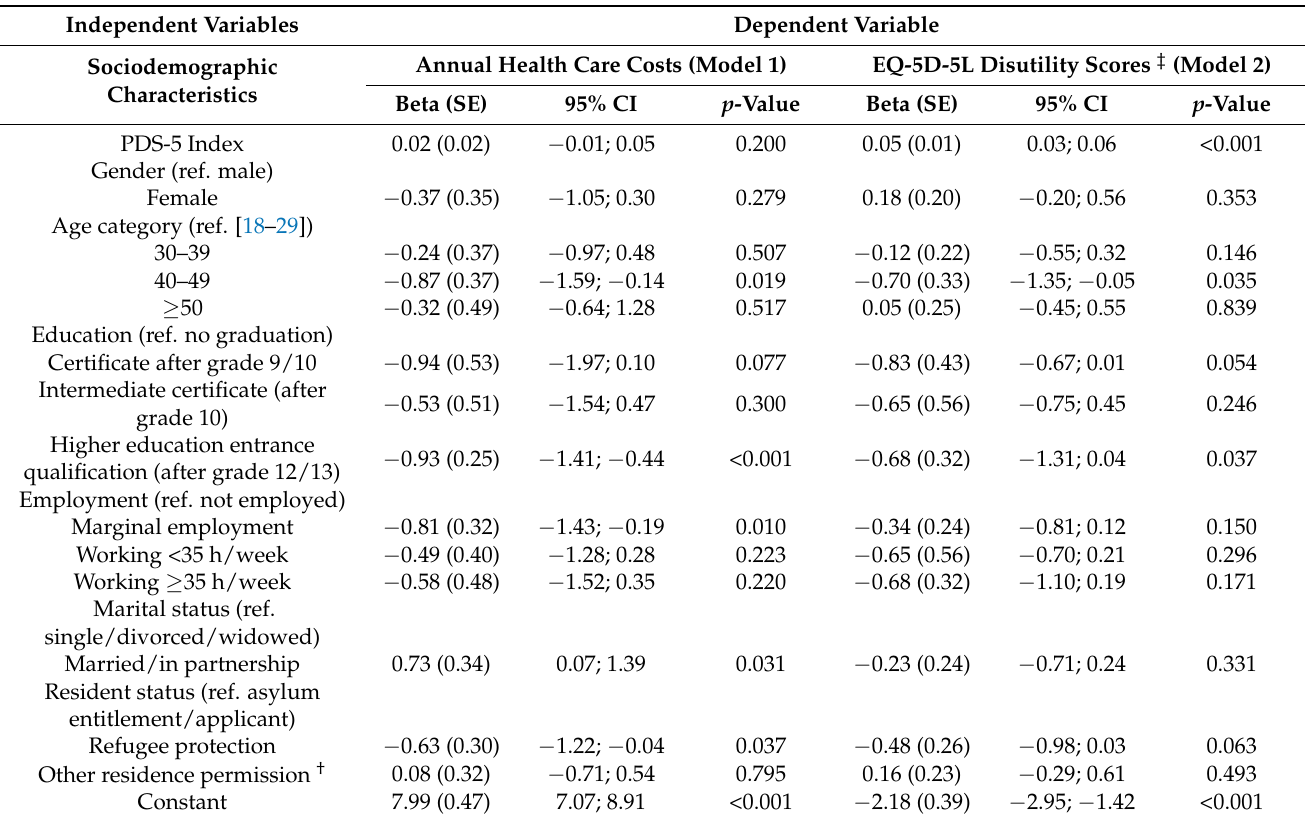
Table 4. Influence of selected sociodemographic characteristics on annual health care costs and EQ-5D-5L disutility scores using generalized linear models with robust standard errors ( n =